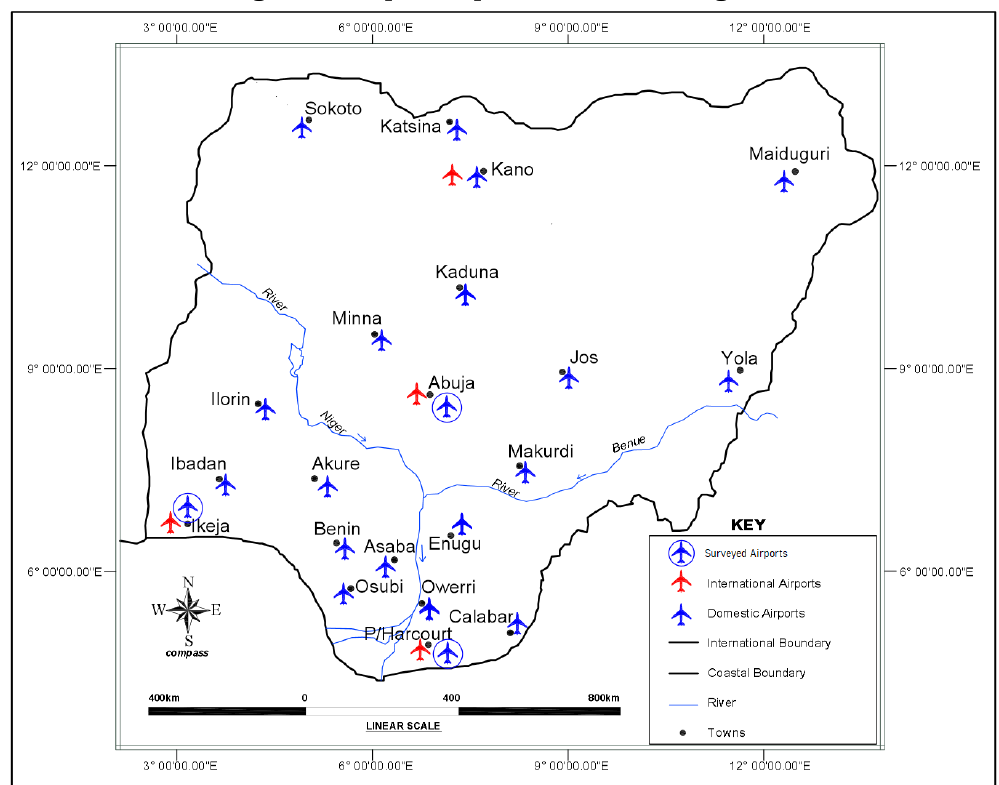
Figure 1: Map of airports location in Nigeria